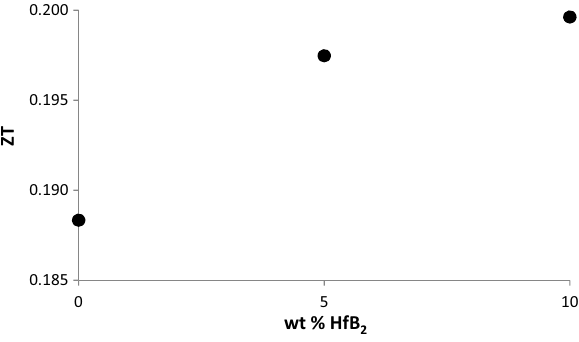
Fig. 8 Figure of merit ZT versus hafnium diboride composition at 750 (cid:3) C